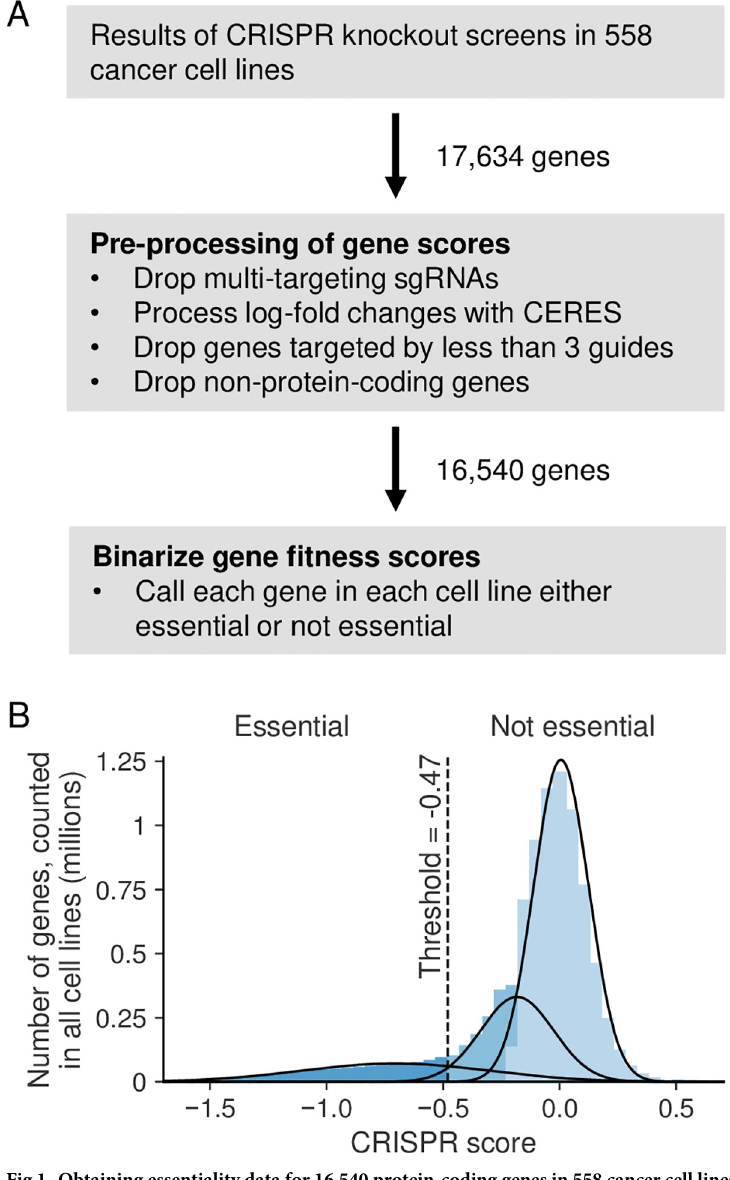
Fig 1. Obtaining essentiality data for 16,540 protein-coding genes in 558 cancer cell lines. (A) Workflow showing how gene scores were pre-processed and subsequently binarized. (B) Histogram showing the distribution of all gene scores across all cell lines. Curves show the 3-components of the Gaussian mixture model fit to this distribution. Colors indicate the component model each region of the histogram was assigned to (differing shades of blue for different components). The threshold (-0.47) used to convert gene scores from continuous values to binary essential and non- essential calls is shown using the dotted